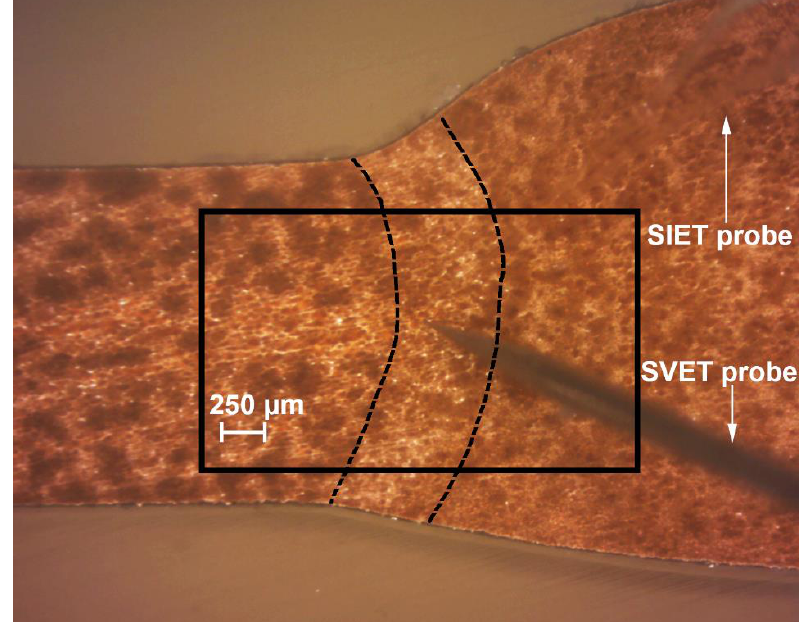
Figure 2. The optical image of the investigated welded joint area of the 1579 aluminium alloy sample with coating obtained using plasma electrolytic oxidation (PEO) before scanning vibrating electrode technique (SVET) and scanning ion-selective electrode technique (SIET) experiments. The